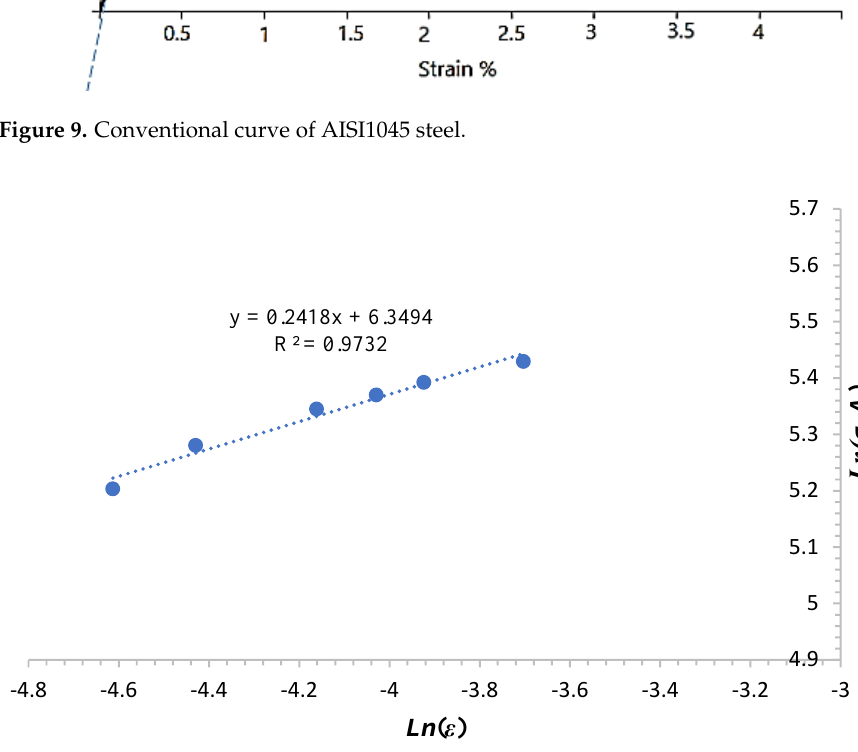
Figure 9. Conventional curve of AISI1045 steel.